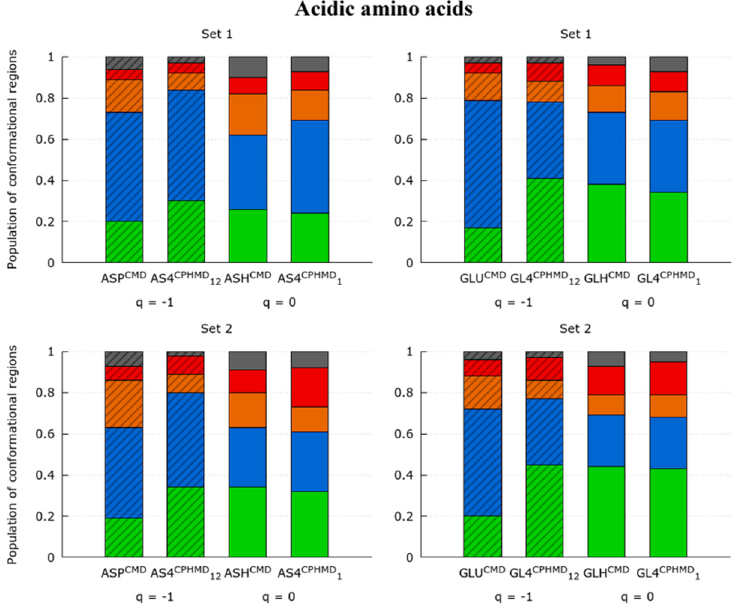
Figure 5. Ratio of the fourth most populated conformational regions (P II , α R , C 7 eq , and C 5 in green, blue, orange, and red, respectively) in the Ramachandran map of the ASP and GLU amino acids. The labeling indicates the residue, the simulation method (in the superscript), and the pH (in the subscript, only for the CPHMD simulations). Subtitles indicate the set of dihedrals corresponding to monomer 1 (N-terminal) or monomer 2 (C-terminal amino acid). Total charge of the tripeptide is indicated below the systems (q = − 1, 0 or +1). The box style (striped or solid) indicates those systems in the same protonation state, independently of the method used. The “others” classification (gray) includes the conformational regions β 2 , α ’, α D , α L , and C 7axial .